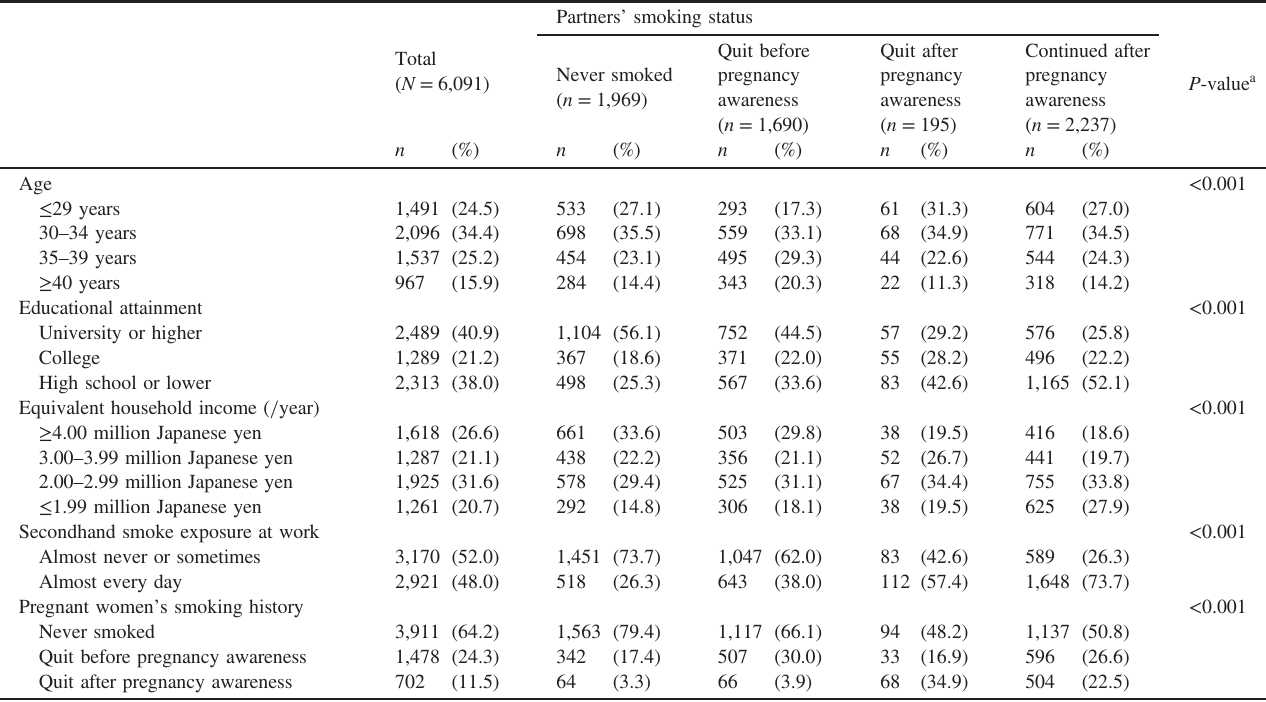
Table 1. Characteristics of the partners of non-smoking pregnant women